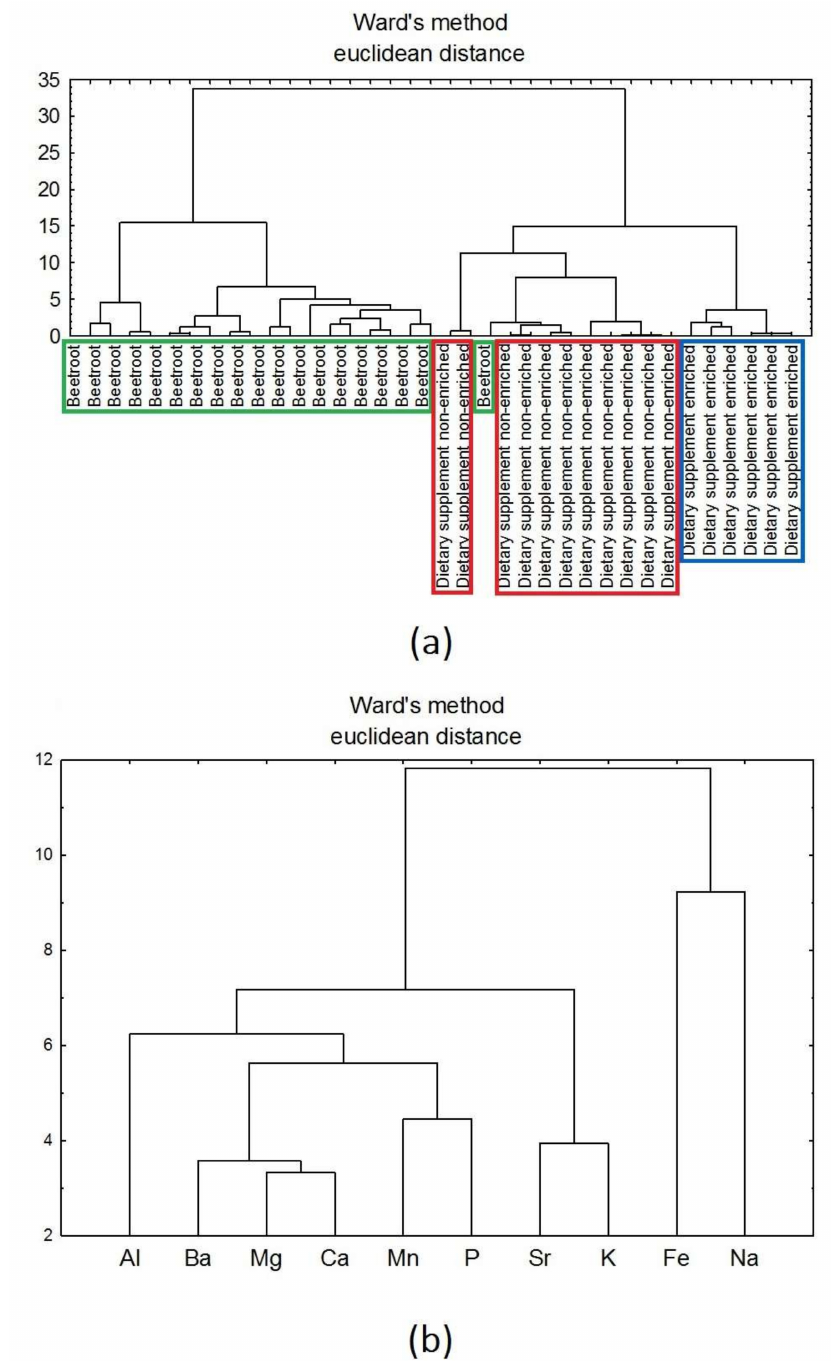
Figure 7. ( a , b ). Hierarchical dendrogram for all products (beetroot and Fe-enriched/non-enriched dietary